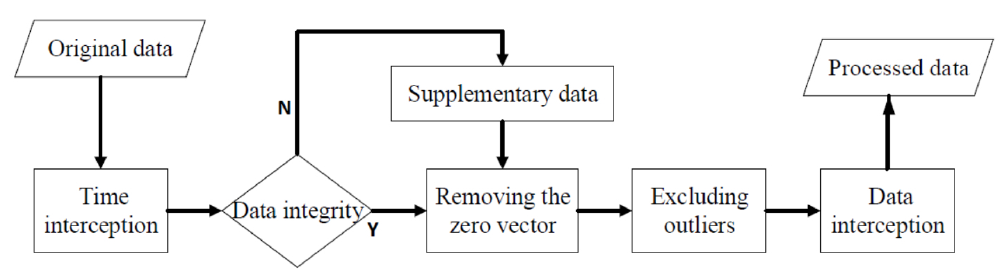
Figure 2. Flowchart of data